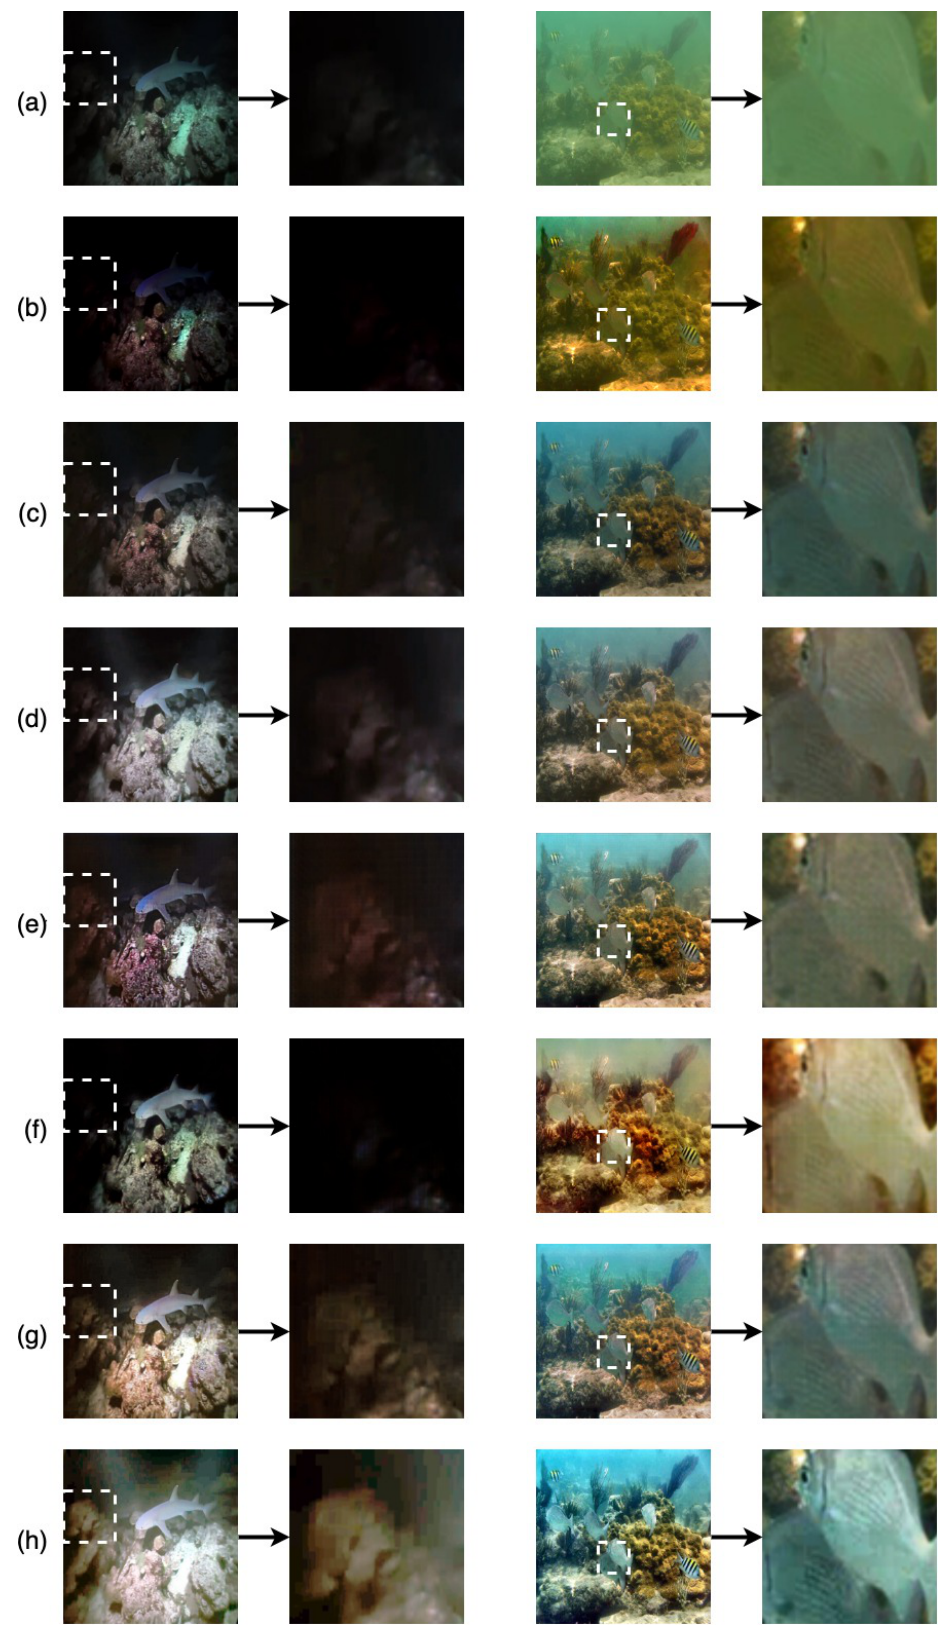
Figure 4. Visual comparison of different images (from Test-R90) enhanced by state-of-the-art methods and our MTUR-Net. ( a ) Raw, ( b ) UDCP [2], ( c ) WaterNet [5], ( d ) Ucolor [9], ( e ) UGAN [11], ( f ) FUniE- GAN [6], ( g ) Ours, ( h ) Ground